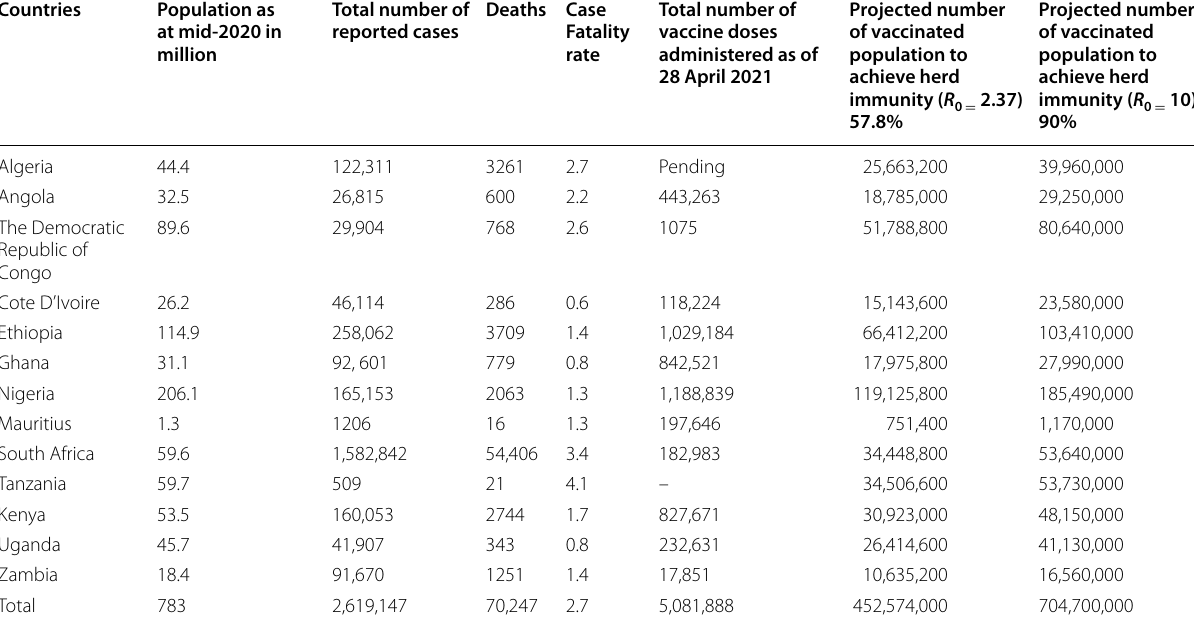
Table 1 Population distribution of the WHO identified 13 priority African countries for COVID‑19, total cases, deaths, CFR, number of vaccine doses administered and projected number of people to be vaccinated